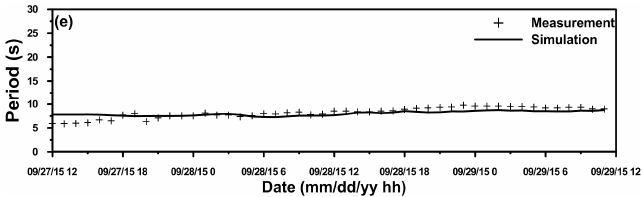
Figure 6. Comparisons of modeled and observed wave periods during: ( a ) Typhoon Saola (2012); ( b ) Typhoon Soulik (2013); ( c ) Typhoon Matmo (2014); ( d ) Typhoon Soudelor (2015); and ( e ) Typhoon Dujuan (2015) at the Keelung buoy.